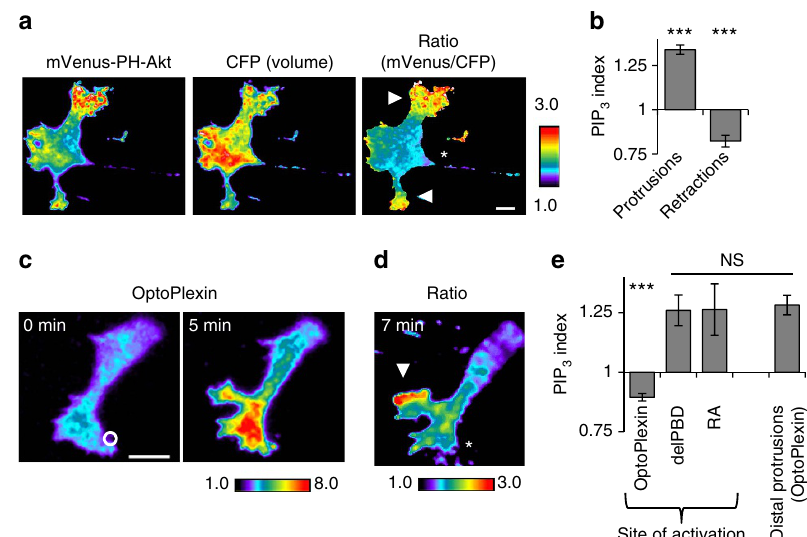
Figure 7 | Local activation of optoPlexin repolarizes PIP 3 . ( a ) TIRF images of mVenus-PH-Akt and CFP (volume marker) in an MC3T3-E1 cell were processed to generate a ratiometric image (mVenus/CFP) that displays the membrane enrichment of mVenus-PH-Akt, indicative of PIP 3 concentration. Asterisk, retraction. Arrowheads, protrusions. Scale bar, 10 m m. ( b ) PIP 3 distribution in protrusions and retractions in MC3T3-E1 cells, as measured by membrane enrichment mVenus-PH-Akt normalized to the whole cell average, n ¼ 9 cells ( c ) TIRF images showing local induction of mCherry-optoPlexin in a MC3T3-E1 cell expressing mCherry-optoPlexin, mVenus-PH-Akt and CFP. Upon induction of CIL, mVenus and CFP images were obtained and processed to generate ratiometric image ( d ) indicating PIP 3 distribution. White circle, region of illumination. Scale bar, 10 m m. Asterisk, induced retraction. Arrowhead, induced protrusion. ( e ) Quantification of PIP 3 indices in a 50 m m diameter circle centred at the region of illumination upon local activation of optoPlexin, optoPlexin-delPBD and optoPlexin-RA; and in distal protrusions induced by local activation of optoPlexin, normalized to whole cell average, n ¼ 8–12 cells. For b , e means ± s.e.m. are shown. *** P o 0.001 and * P o 0.05, NS, not significant, Student’s t